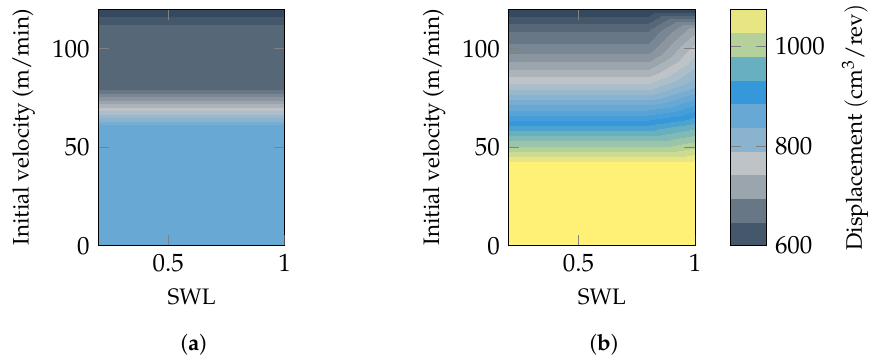
Figure 11. Motors’ displacement for the results shown in Figure 10: ( a ) Classic; ( b )